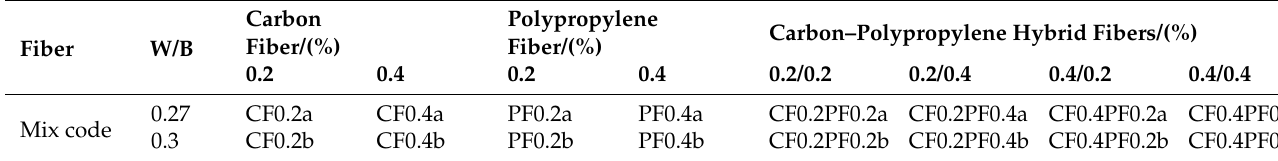
Table 4. Fiber addition in LWAC